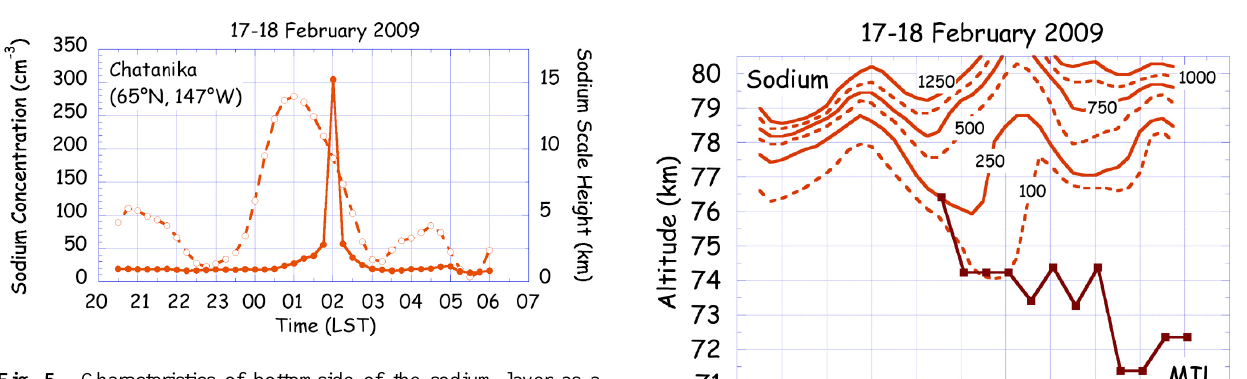
Fig. 5. Characteristics of bottomside of the sodium layer as a function of time (LST=UT − 9h) measured by resonance lidar at Chatanika, Alaska on the night of 17–18 February 2009. The sodium concentration averaged over the 76–77km altitude range (dashed line with open circle) and the sodium scale height over the 75–78km altitude range (solid line with full circle) are plotted. Fig. 6. Altitude of sodium concentration contours (alternate solid